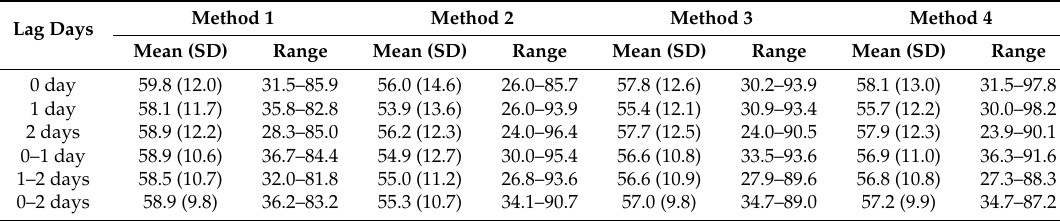
Table 2. Distributions of O 3 concentrations measured on lung function test day, 1 day, 2 days, 0–1 day, 1–2 days and 0–2 days by the four different